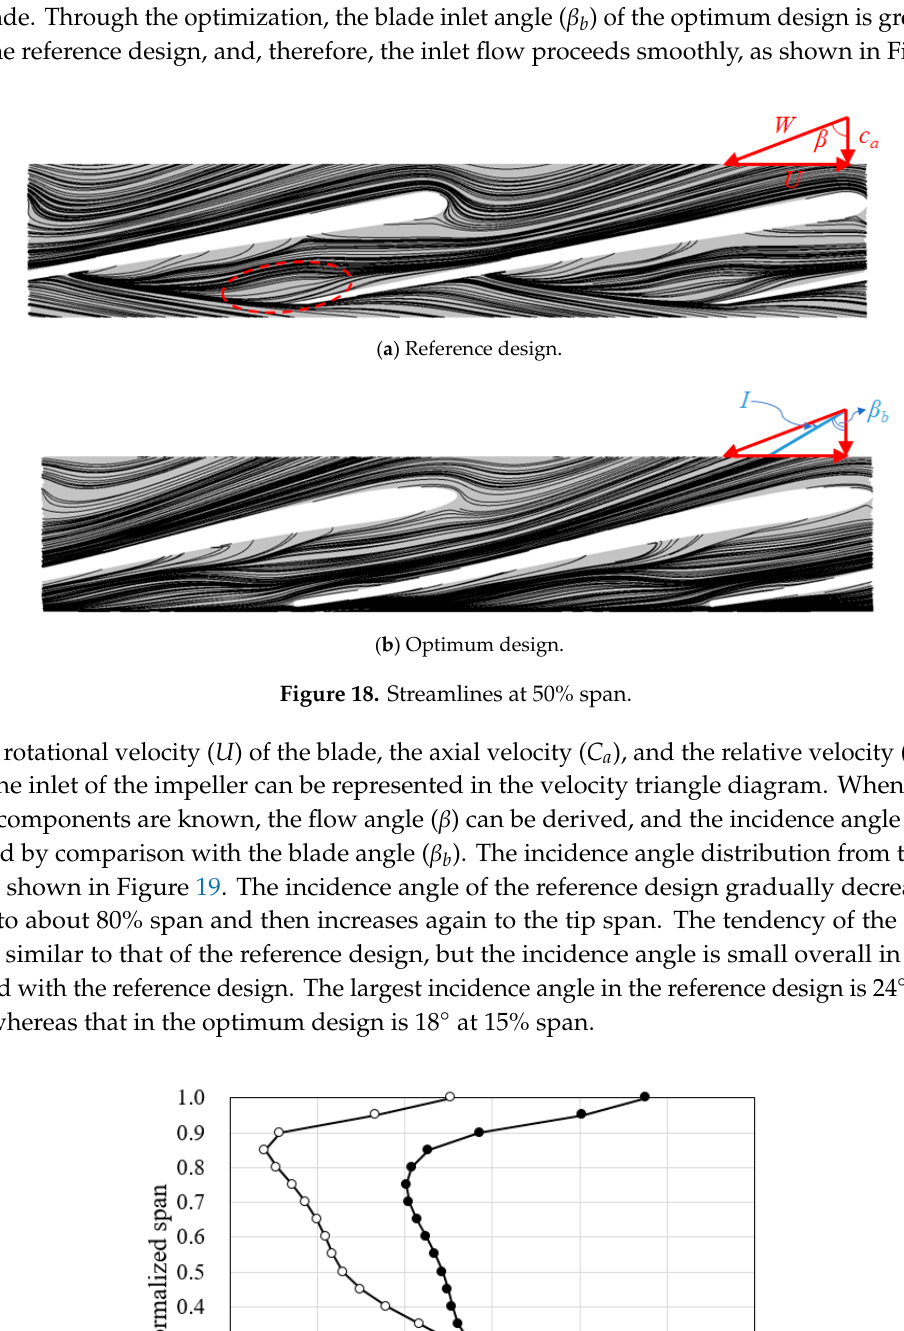
Figure 17. Velocity distributions at 50% span.